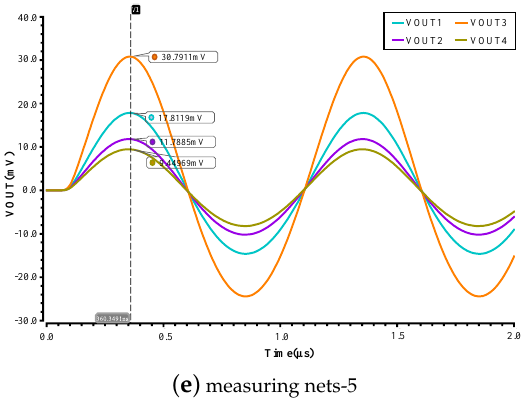
Figure 11. Simulation results for the top-level schematic.